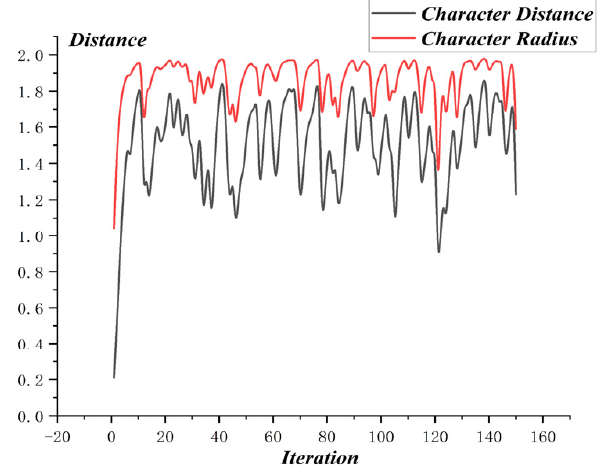
Figure 10. Optimization process of MO-PSO.